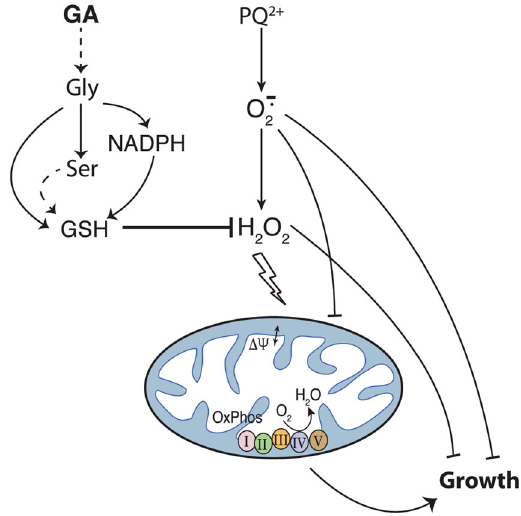
Fig. 9 Scheme of the proposed pathway for the glycolate-mediated antioxidant activity. Upon exposure to PQ 2 + , superoxide (O 2 . − ) is produced that, in turn, can generate H 2 O 2 (see text). Both ROS molecules disturb the mitochondrial activity (oxygen consumption rate and mitochondrial membrane potential, ΔΨ ) and animal growth rate. Exogenously added glycolate (GA) is converted into glycine and serine. This triggers the NADPH/NADP + ratio that together with the generation of the building blocks for GSH synthesis, glycine and L -cysteine (the latter produced form L -serine), increase the GSH/GSSG ratio. The boosted GSH levels counteract the deleterious effects of H 2 O 2 on mitochondrial function and growth but not those of superoxide